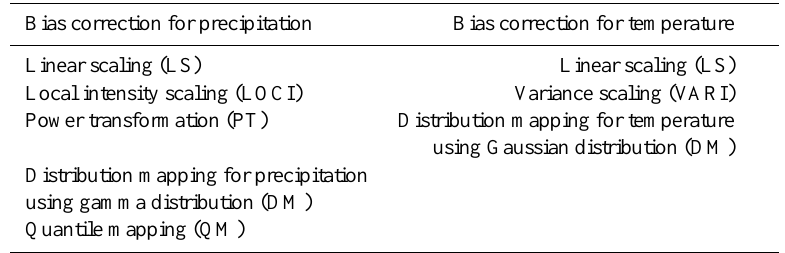
Table 2. Bias correction methods for RCM-simulated precipitation and temperature. Bias correction for precipitation Bias correction for temperature Linear scaling (LS) Linear scaling (LS) Local intensity scaling (LOCI) Variance scaling (VARI) Power transformation (PT) Distribution mapping for temperature using Gaussian distribution (DM) Distribution mapping for precipitation using gamma distribution (DM) Quantile mapping